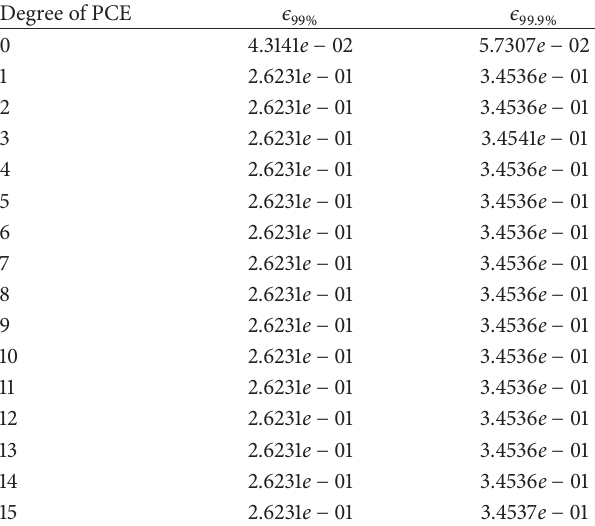
Table 6: Absolute error of the average and the variance of 𝑅 (𝑝) 𝑇 at time 𝑇 = 1 , with respect to Vasicek parameters 𝛼 = 0.1 , 𝛽 = 0.2 , and 𝜎 = 0.15 .